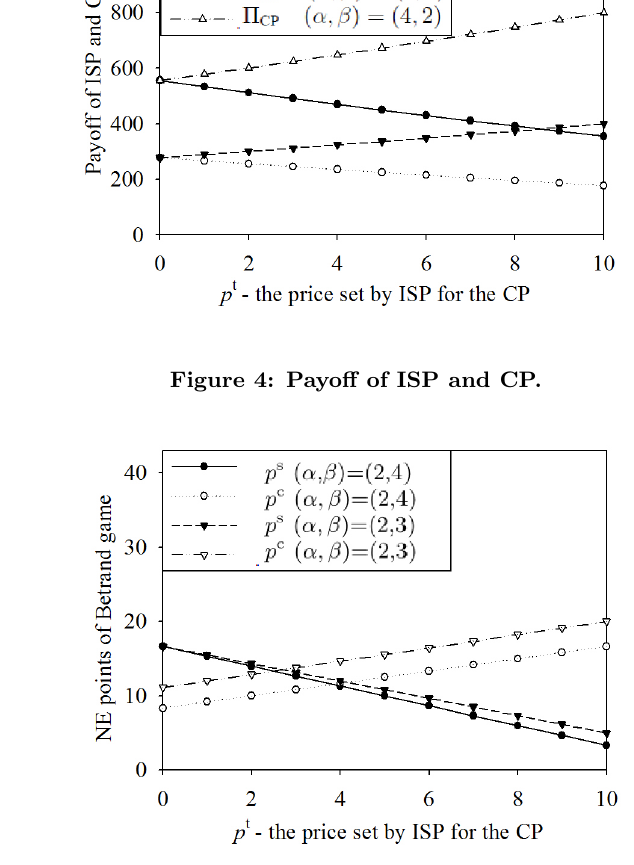
Figure 5: NE point prices of ISP and